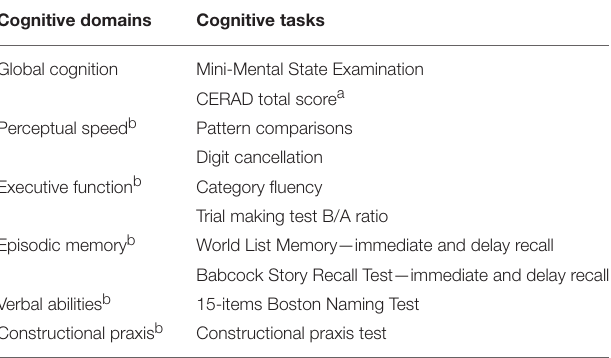
TABLE 1 | Overview of the cognitive domains and related tasks in the NU-AGE